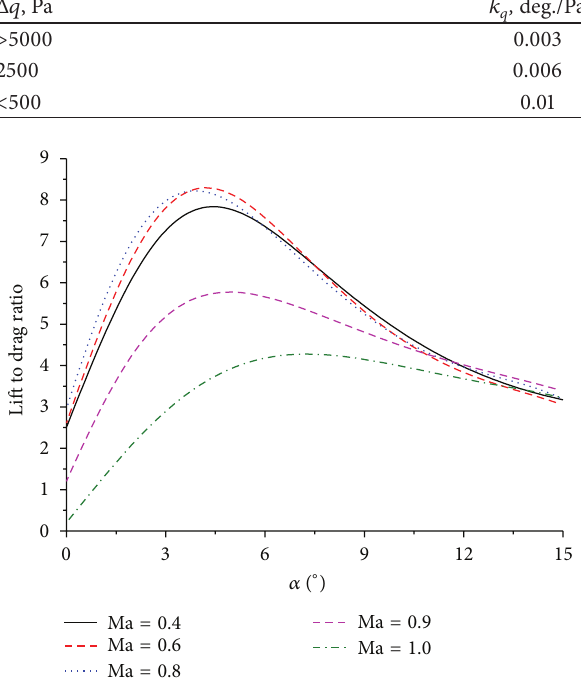
Figure 3: 𝐿/𝐷 versus angle of